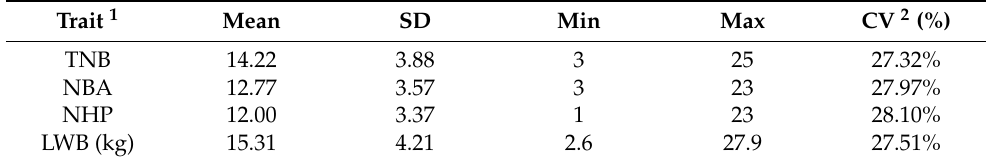
Table 1. Descriptive statistics of four litter traits. Trait